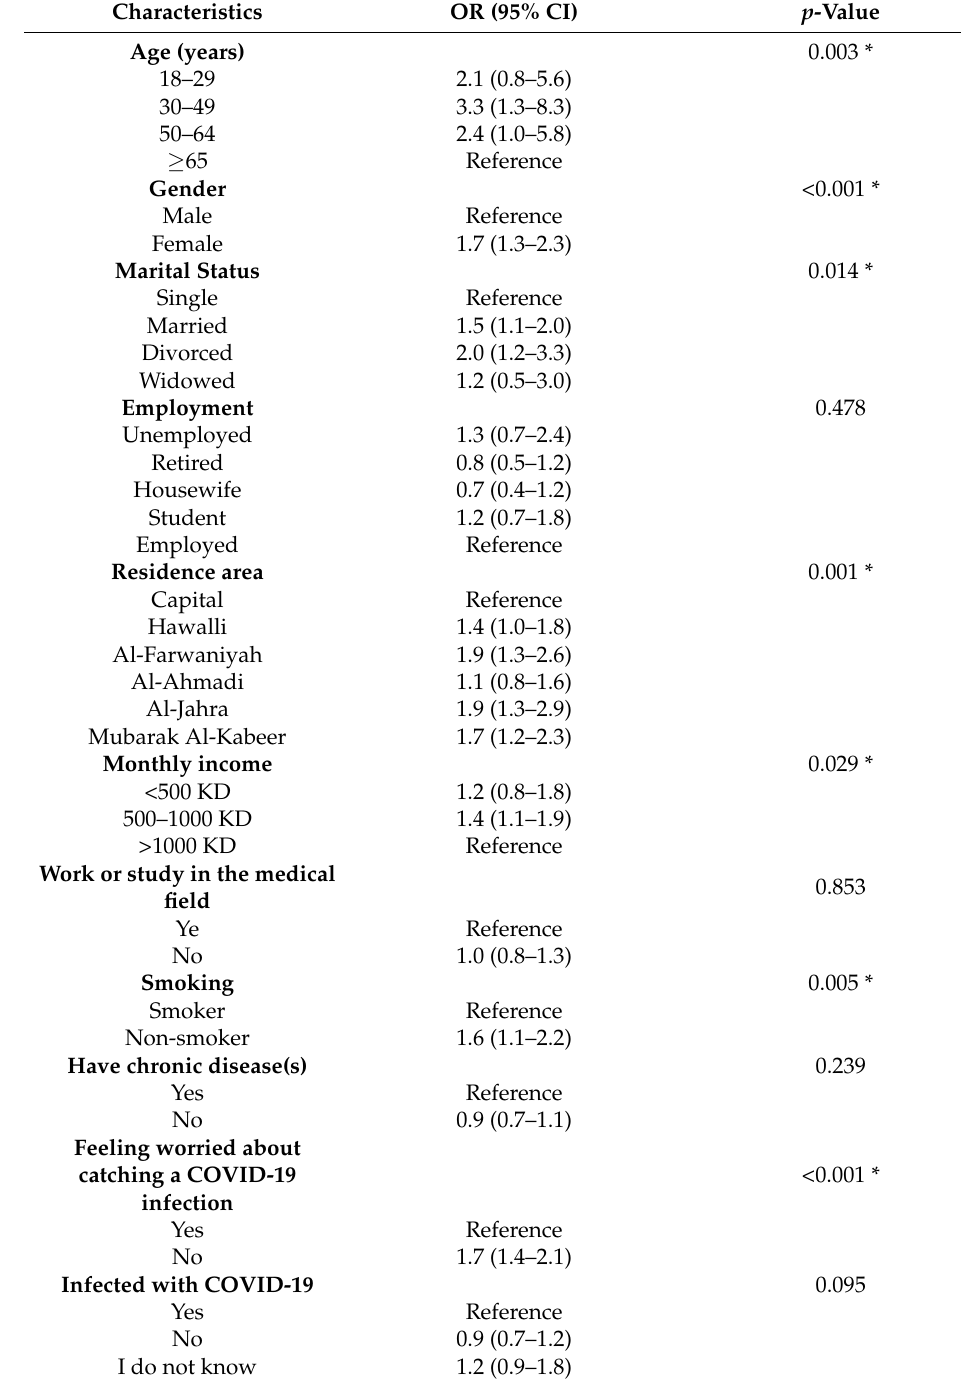
Table 6. Multivariable logistic regression for the predictors of uncertainty and unwillingness to vaccinate against the COVID-19 infection ( n =